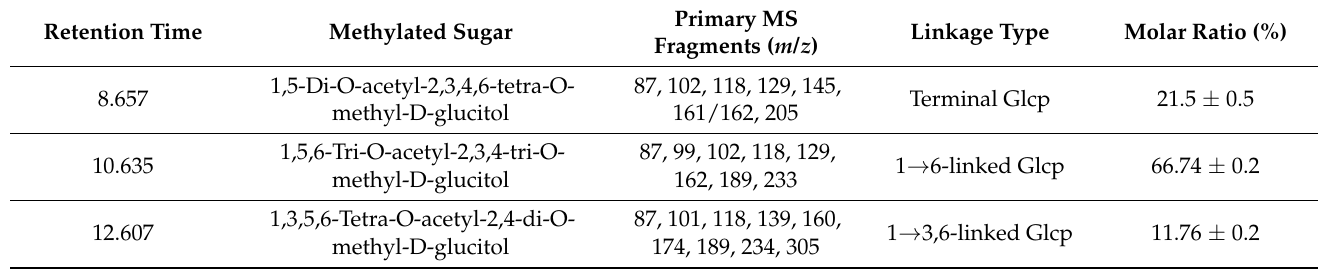
Table 1. Linkage analysis of Apilactobacillus waqarii EPS by methylation and